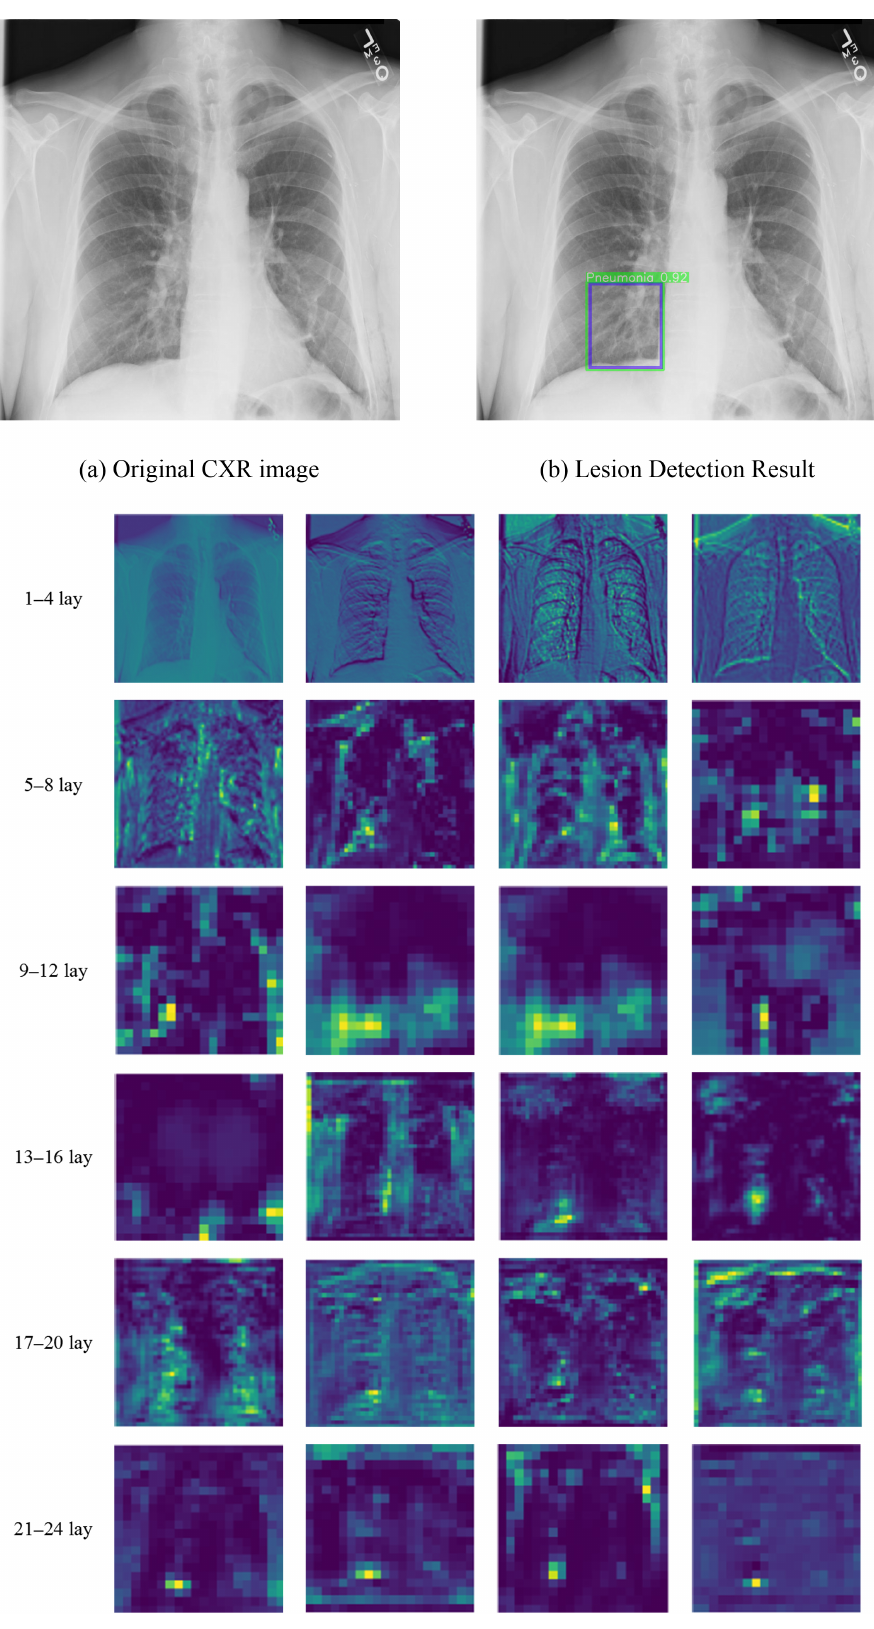
Figure 5. Visualization of intermediate feature map produced by our SAS-MFF-YOLO model. ( a , b ) show the original CXR image and pneumonia-related lesion detection result. The heatmaps show the feature maps in which the yellow color indicates potentially important areas for pneumo- nia